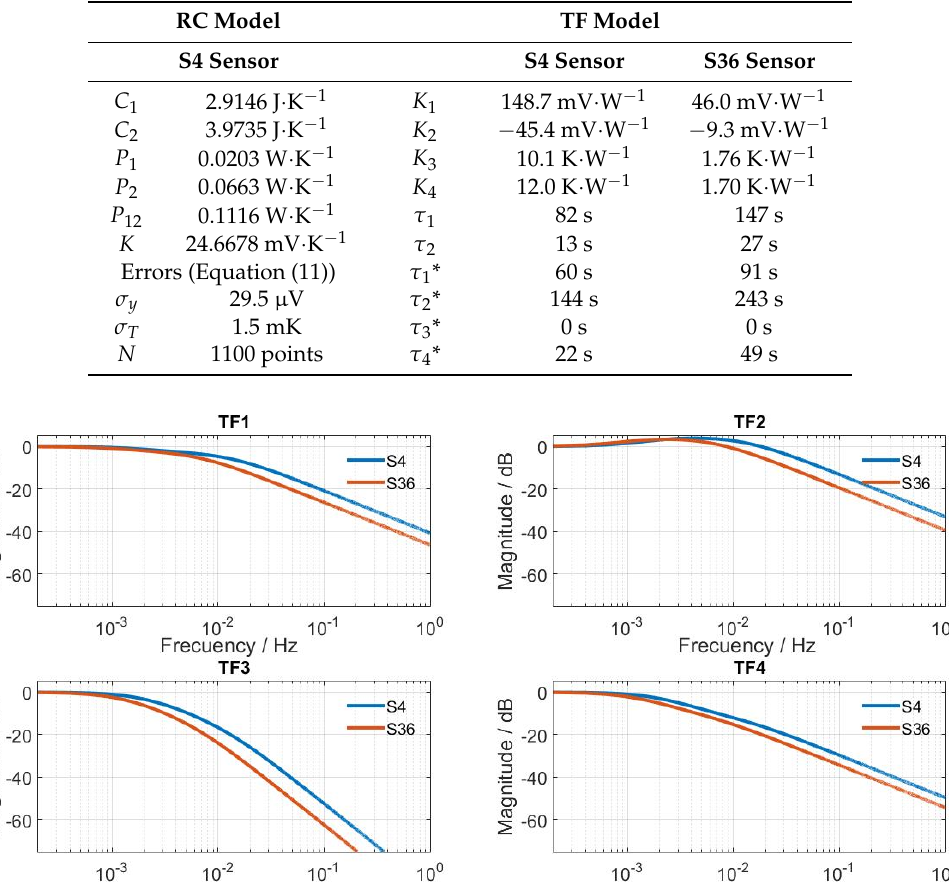
Table 1. Calibration results. RC model (Equation (7)) and TF i (Equation (5)) parameters. S4, the minisensor described in this study; S36, an earlier 36 cm 2 model (Reference [5]).